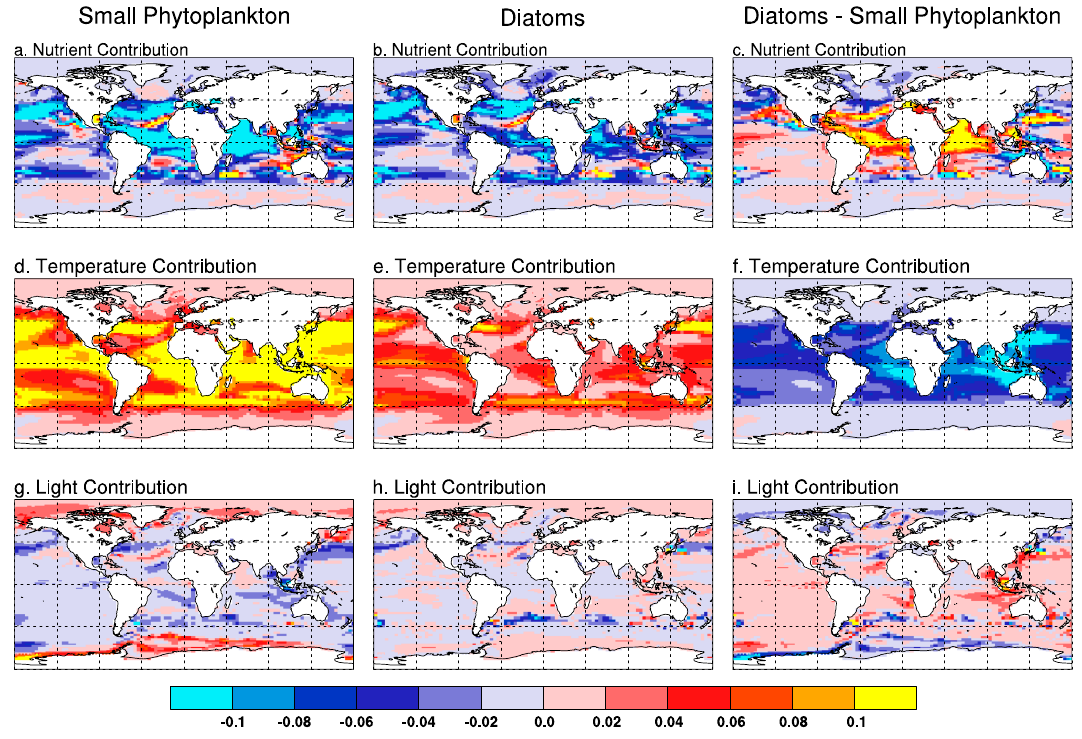
Fig. 6. What drives the 1980 to 2100 change in phytoplankton specific growth rate? Shown are the (a, b, c) nutrient contribution 1µ nutr x ; (d, e, f) temperature contribution 1µ temp x ; (g, h, i) light contribution to the growth rate trend 1µ light x . All contributions calculated from the respective 1980–2100 modeled linear trends multiplied by 120 years, in units of day − 1 , and shown for small phytoplankton (left panels), diatoms (middle panels), and the difference between diatoms and small phytoplankton (right hand